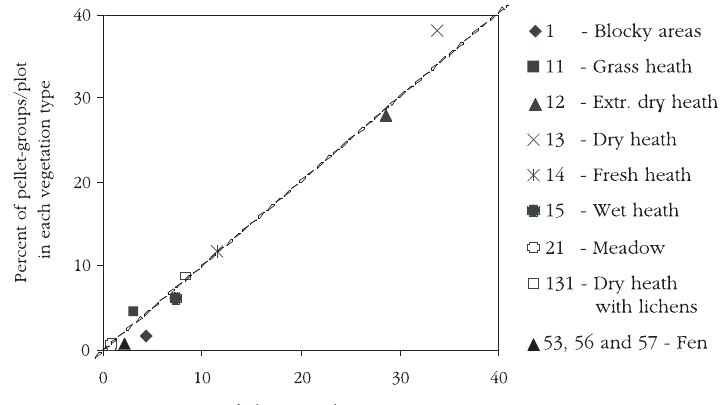
Fig. 3. The relative number of pellet-groups in different vegetation types plotted against the relative number of plots found in each vegetation type. The diagonal line is a 1/1 line.